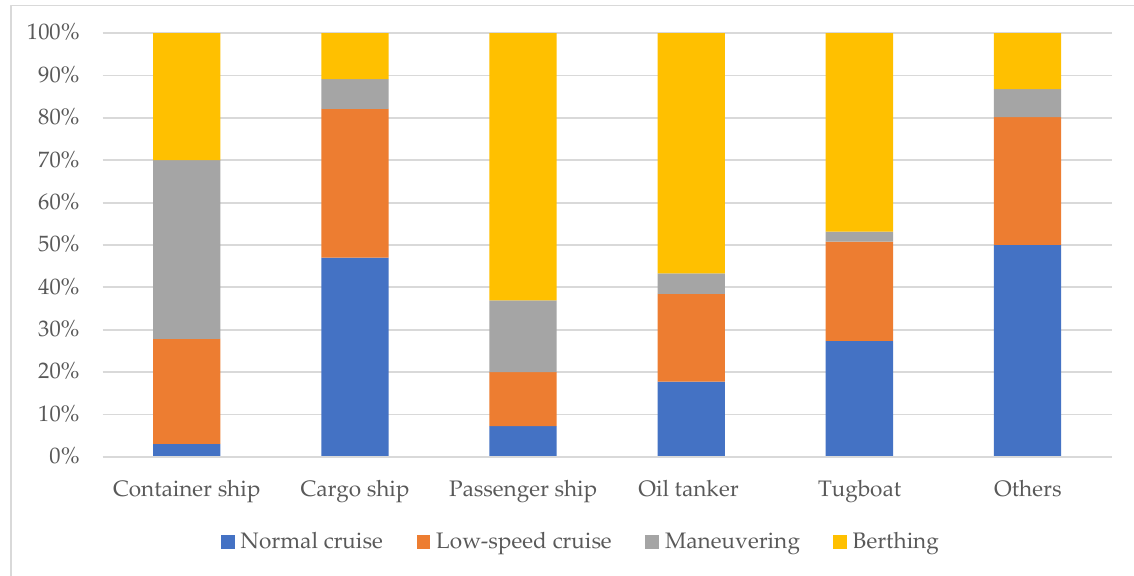
Figure 10. Comparison of CO emissions in different sailing states.